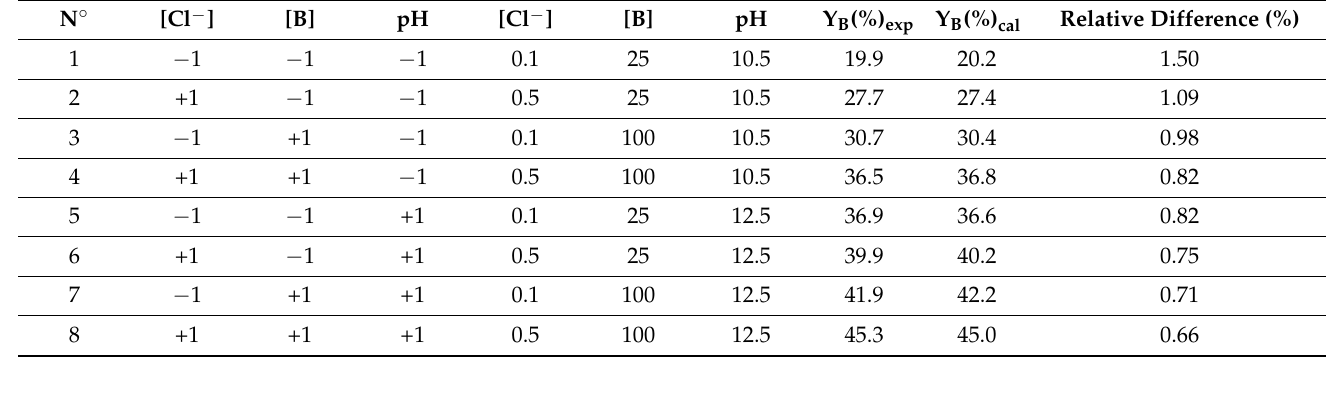
Table 3. Full factorial design matrix.